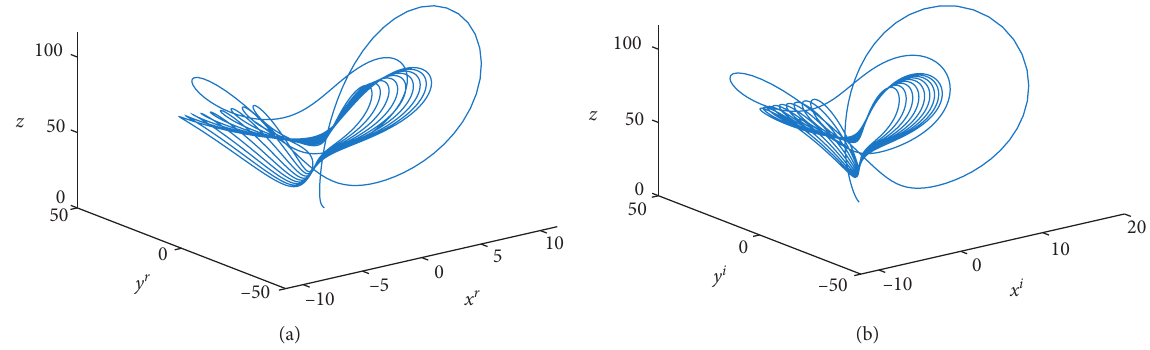
Figure 1: A complex-valued Lorenz system is illustrated. (a) The image part of the states. (b) The real part of the